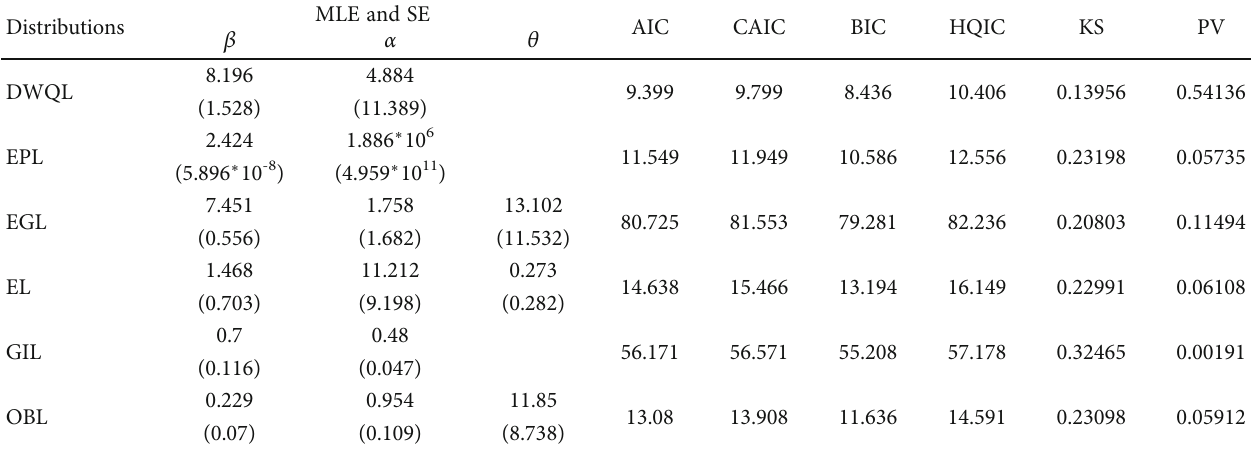
Table 11: MLEs, SEs, and measures of fi tting for the fi rst data set.